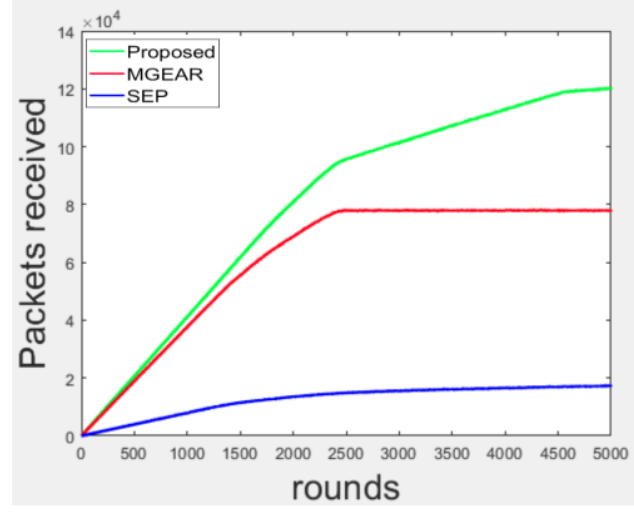
Figure 5. Packets received by the BS per round.